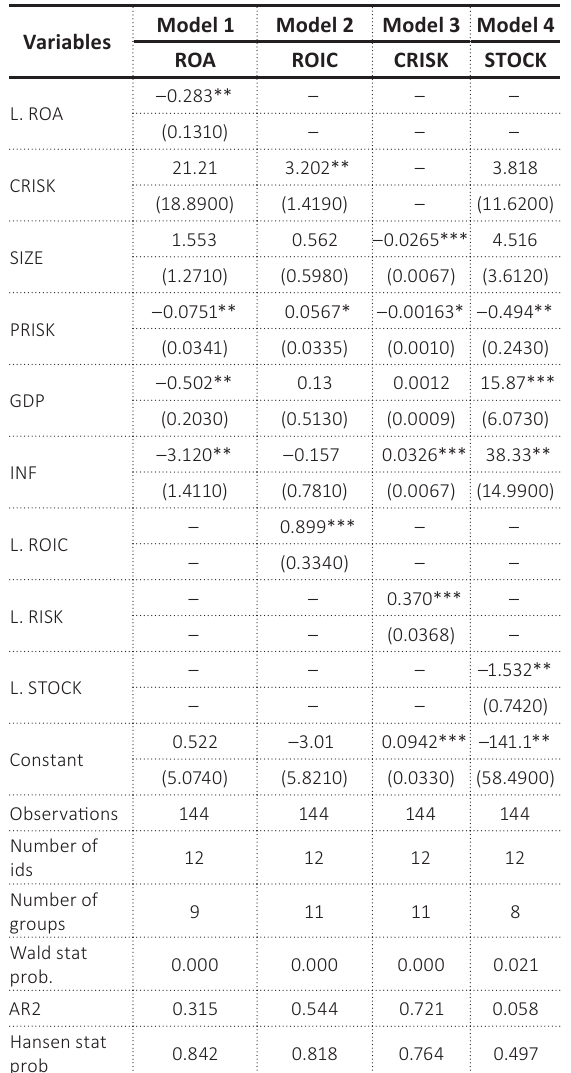
Table 3. GMM regression